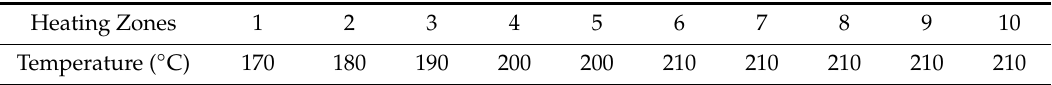
Table 1. The temperatures of heating zones of twin-screw extruder.